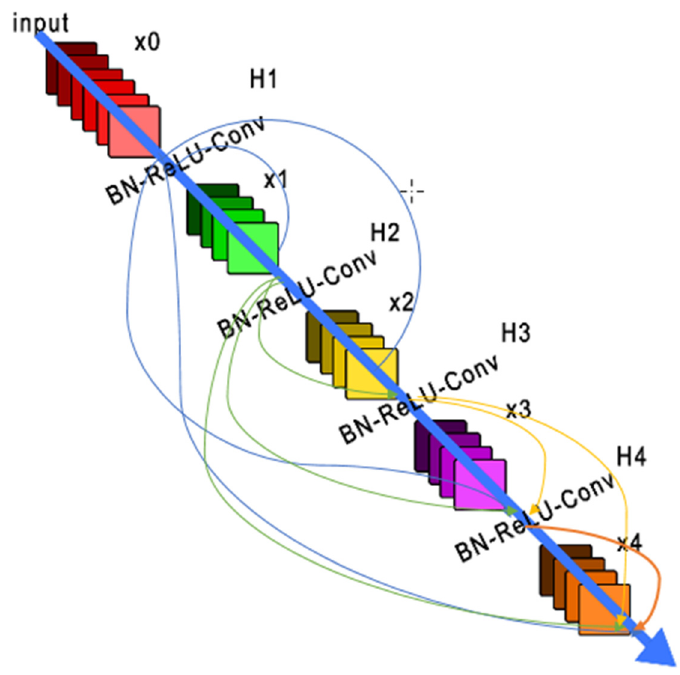
Figure 5. A 5-layer dense block with a growth rate of k = 4. Each layer takes all preceding feature- maps as input.